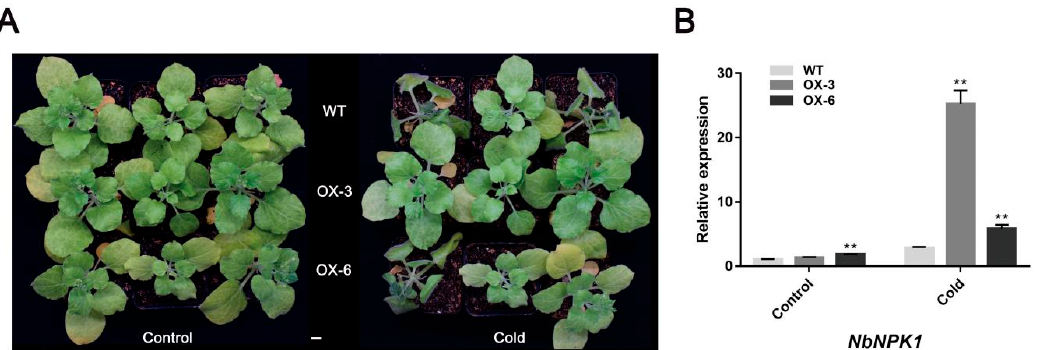
Figure 6. Comparison of 35S::FaNAC2 and WT plants under cold stress. ( A ) Phenotypes of 35S::FaNAC2 lines and WT under control and cold conditions. ( B ) Expression of NbNPK1 related to plant resistance to cold pathways in 35S::FaNAC2 lines and WT under cold treatment. The scale bar represents 1 cm. Bars are means (±S.D.) of three independent experiments (Student’s t -test; ** p < 0.01). Plants 2020 , 9 , x FOR PEER REVIEW